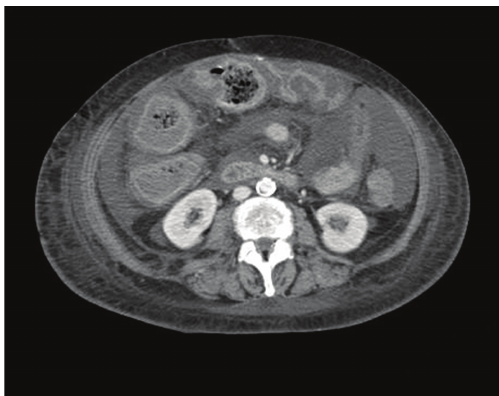
Figure 1: A CT-scan of the abdomen showing increased thickness of the colonic